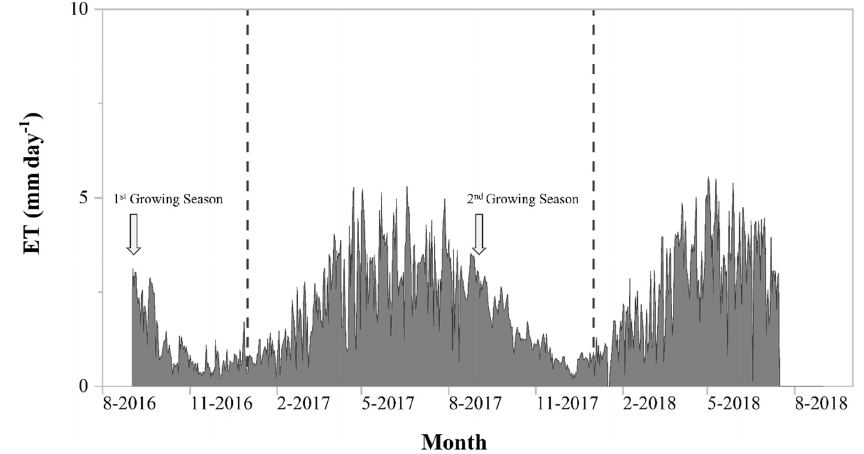
Figure 5. Daily cumulative evapotranspiration (ET) of a grass-dominated grassland ecosystem from the 2016–2017 and 2017–2018 growing seasons located in Middle Tennessee. Dashed lines separate calendar years from each other. The end-of-spring season biomass production were 5.7 and 6.4 Mg ha − 1 in April and peaked at 8.2 and 9.8 Mg ha − 1 in May in the first and second growing seasons; respec- tively (Figure 6).